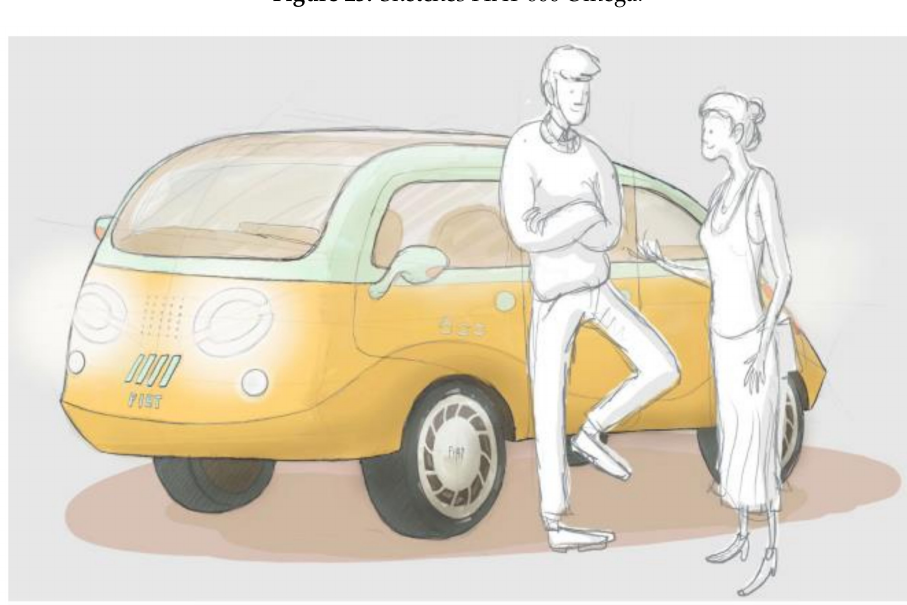
Figure 24. New FIAT 600 Omega: final